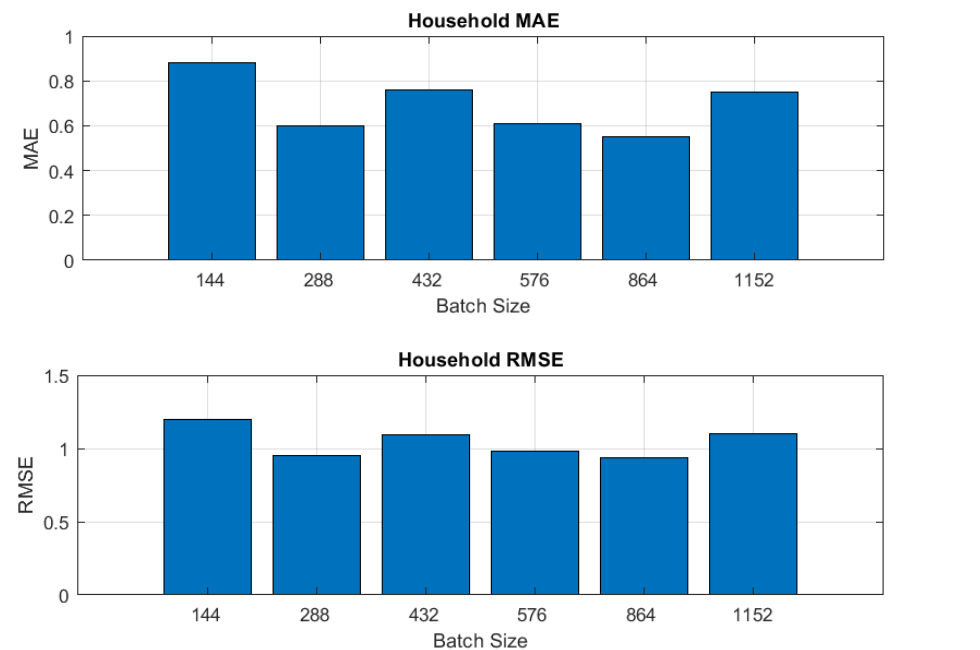
Figure 5. Metrics for the Household case: Household MAE and Household